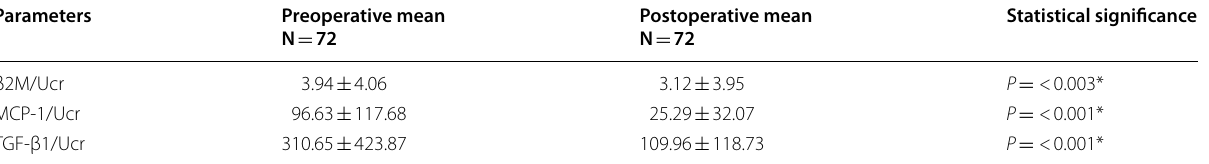
Table 1 Comparison of β 2 M, MCP-1 & TGF- β 1 before and after pyeloplasty